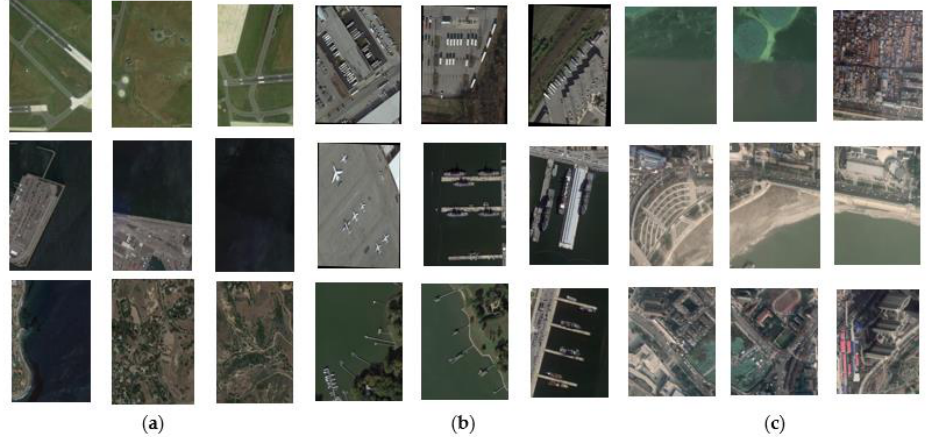
Figure 12. Remote sensing images of parts of the three datasets. ( a ) NWPU VHR-10 [39]; ( b ) DOTA [40]; ( c ) CHN6-CUG [41]. Each dataset is collected in different scenarios, such as air- port, sea area, wharf, city road, farmland,